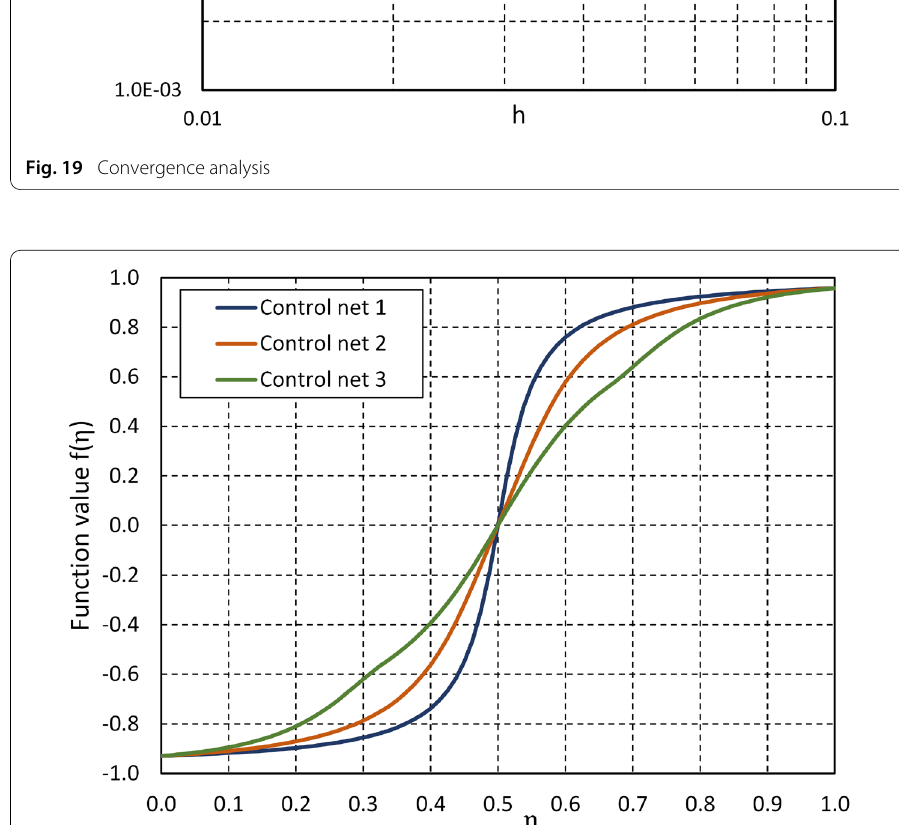
Fig. 20 Function distribution along the coordinate